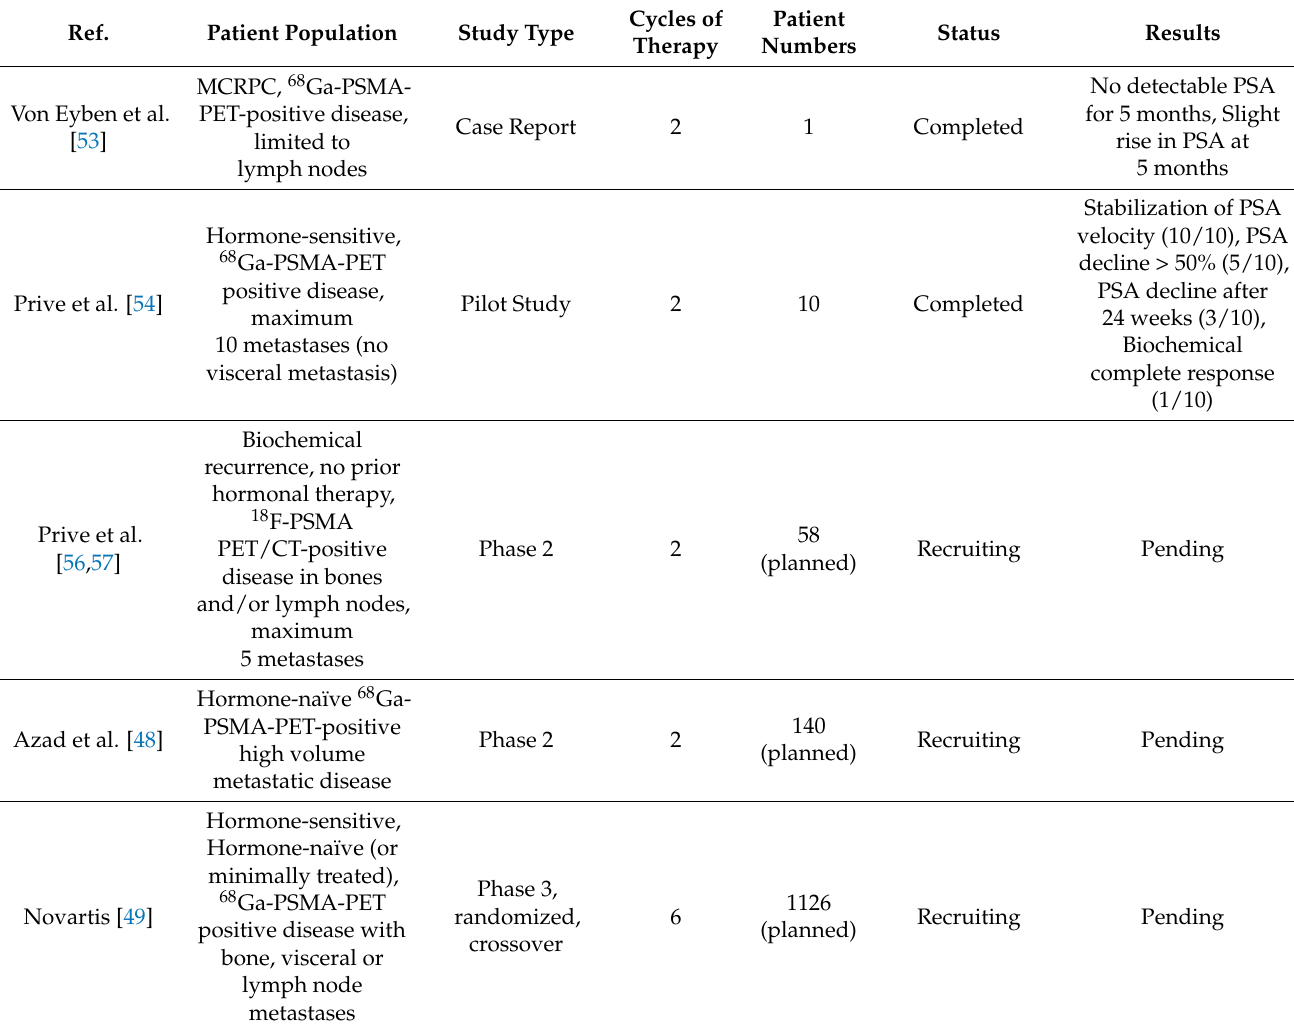
Table 1. 177 Lu-PSMA-617 in metastatic, hormone-sensitive prostate cancers.